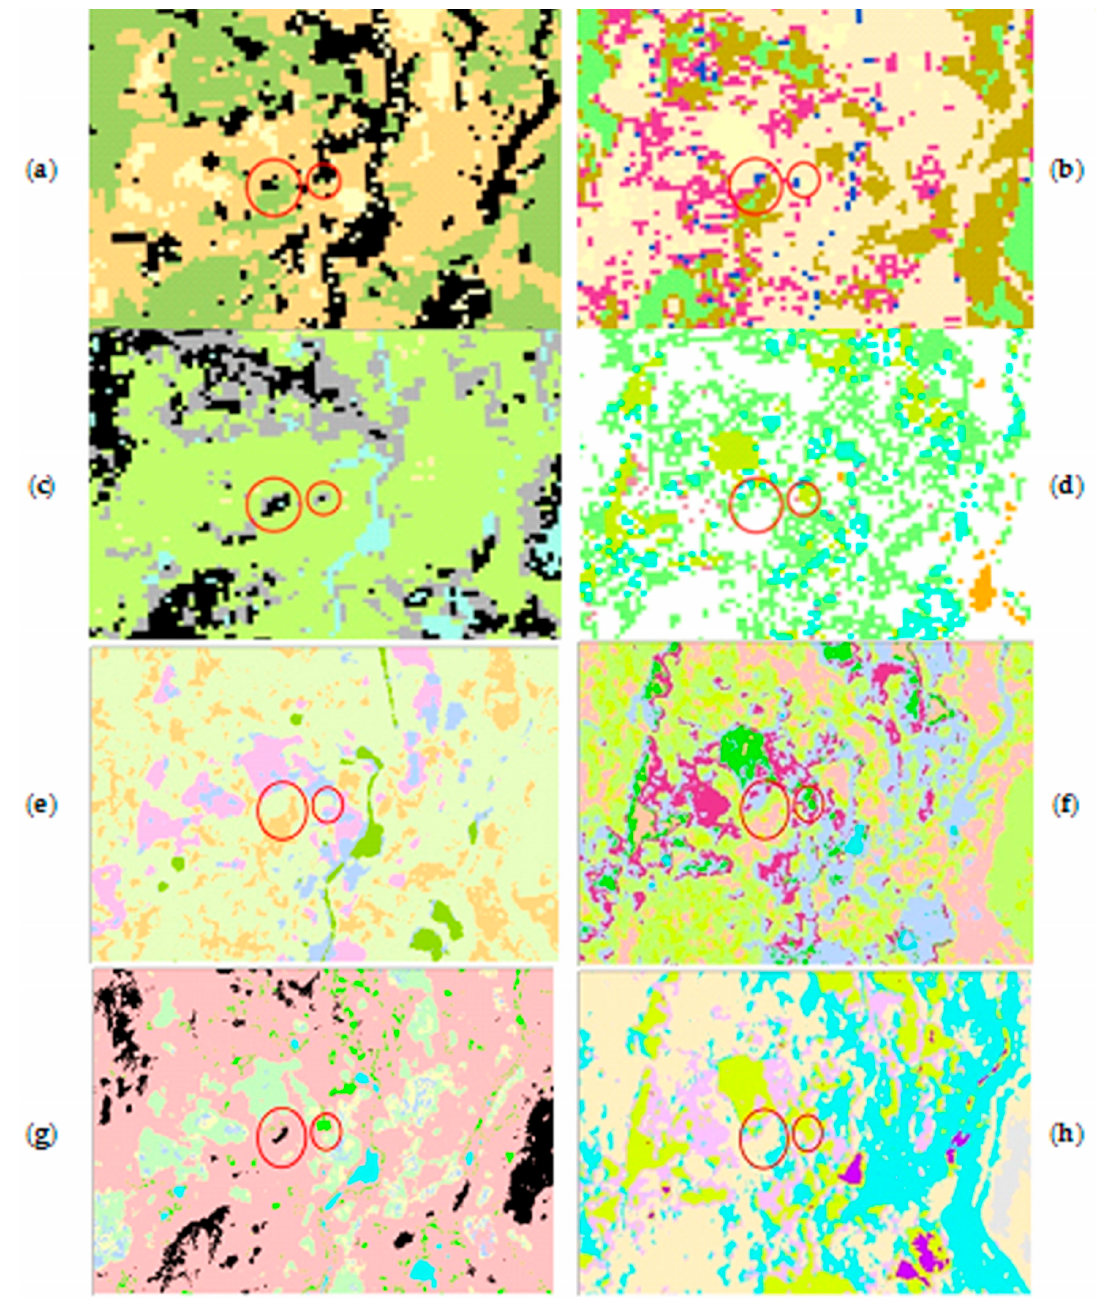
Figure 11. Maximum likelihood classification for Greek study areas; ( a ): ML classification using Sentinel-2 RGB image in February, ( b ): ML classification using Sentinel-2 RGB image in August, ( c ): ML classification using Sentinel-2 Composite 3 in February, ( d ): ML classification using Sentinel-2 Composite 3 in August, ( e ): ML classification using PlanetScope RGB image in February, ( f ): ML classification using PlanetScope RGB image in August, ( g ): ML classification using PlanetScope Composite 3 in February, ( h ): ML classification using PlanetScope Composite 3 in August; OMW disposal areas are indicated inside the red